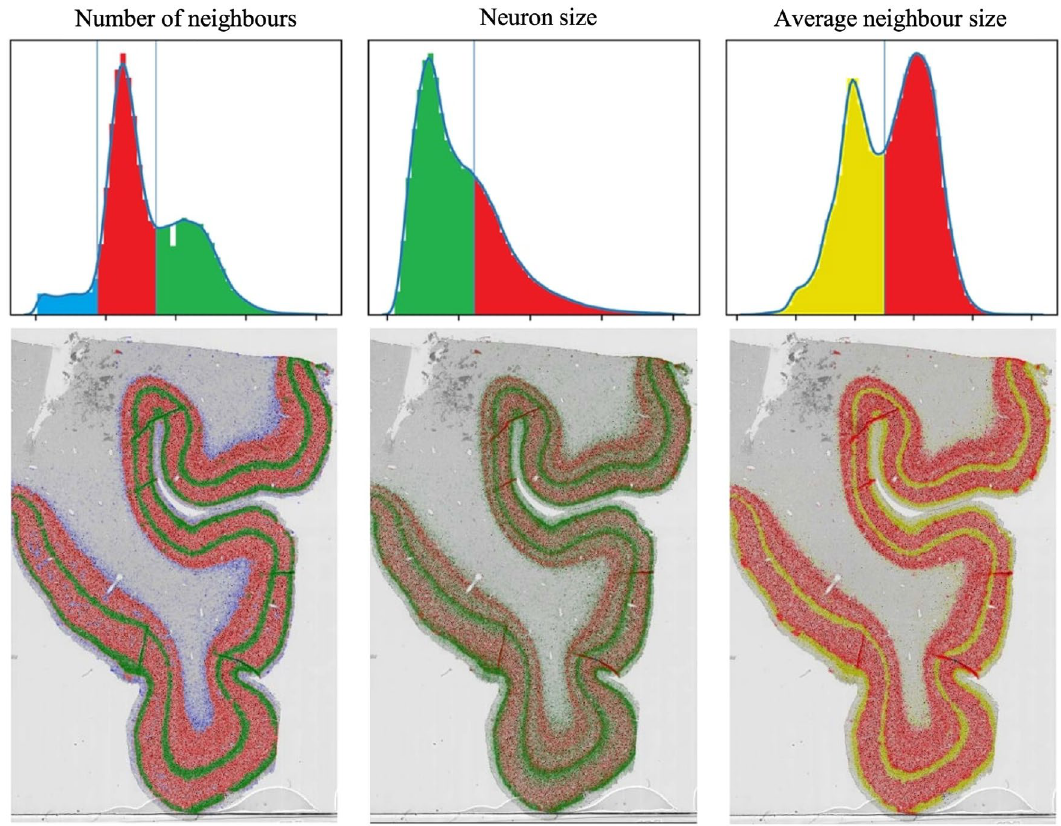
Figure 2. By visualizing the basic neuronal characteristic, the area, and local density, the laminar structure is revealed, as these features exhibit multimodal distributions. Left: Three types of neurons were distinguished by cell density in their surroundings: very sparse (blue), sparse (red), and dense (green). Middle: Larger (red) and smaller (green) neurons. Right: Average size of neighboring neurons is a feature obtained from the previous two: nearest neighboring neurons and their areas, which can also be used to facilitate layer prediction. Here, thresholds that separate the distributions were obtained using minimization of intraclass variance 26